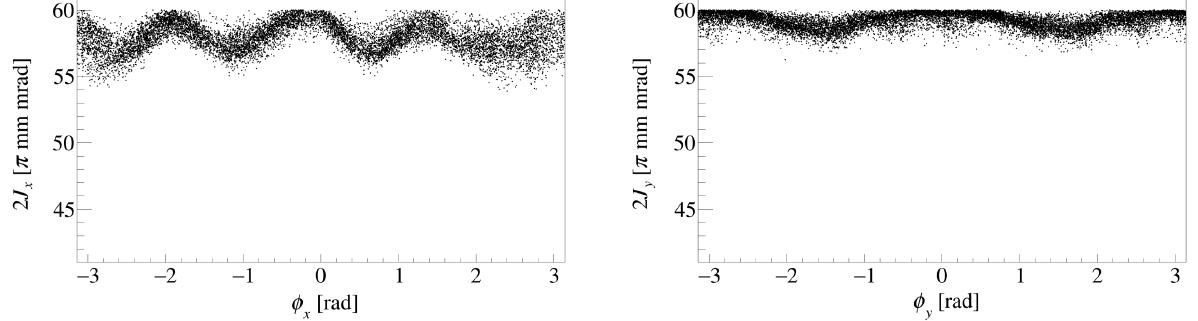
FIG. 10. Simulated phase space distributions of the lost particles with J x > J y (left) and J x < J y (right) with the new optics, displayed in action-angle coordinates. The last 15 turn positions before the particles were lost are plotted.